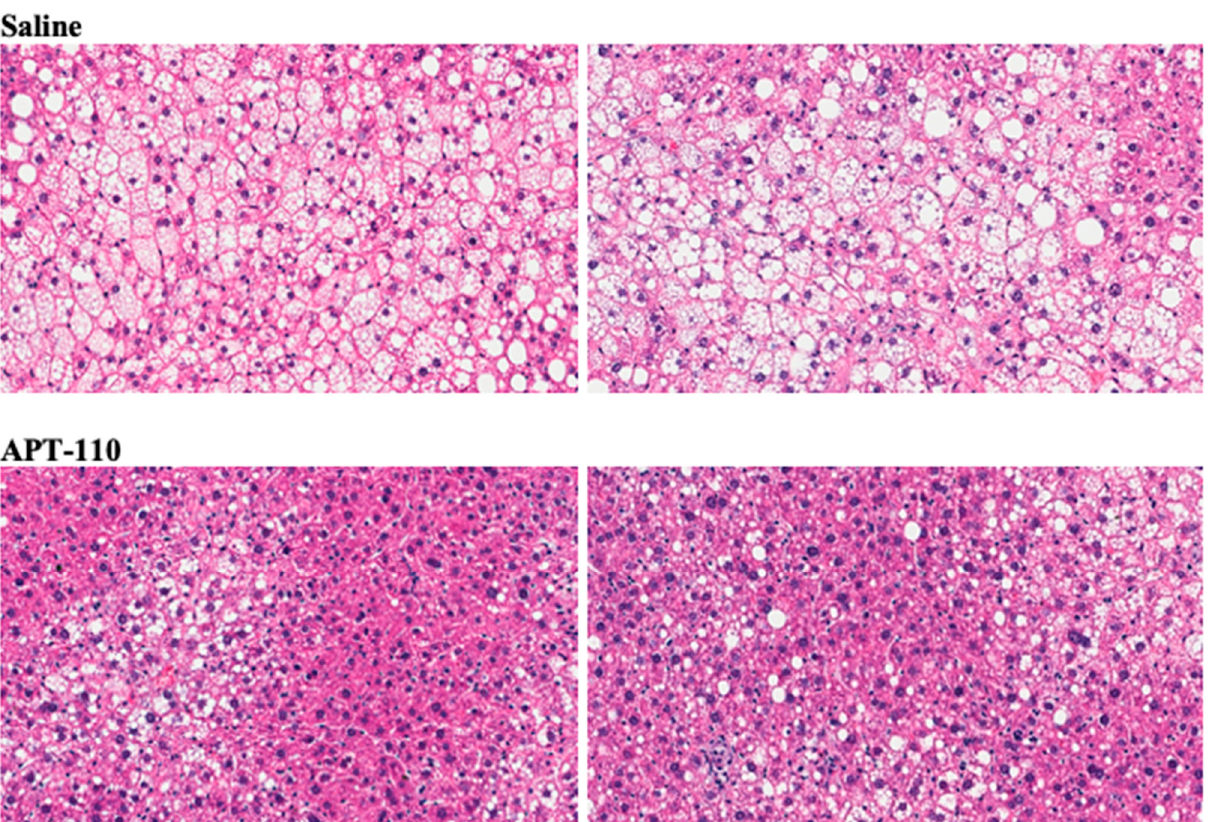
Figure 6. Histologic appearance of livers (H&E staining) at the end of 12 weeks of treatment in mice receiving SC injections of saline or the APT-110 miR-22-3p inhibitor (two samples from each group are shown), reprinted from Reference [60], an open-access article distributed in accordance with the